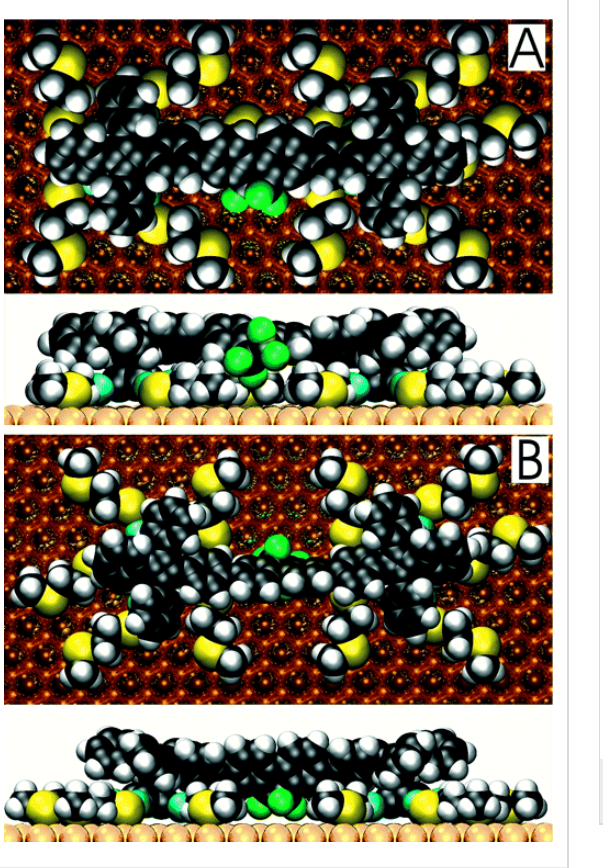
Figure 29: Optimized representative eclipsed (A) and staggered (B) conformations of the MMP diastereomer of 52 on Au(111). Reprinted with permission from [97], copyright 2004 American Chemical Society.